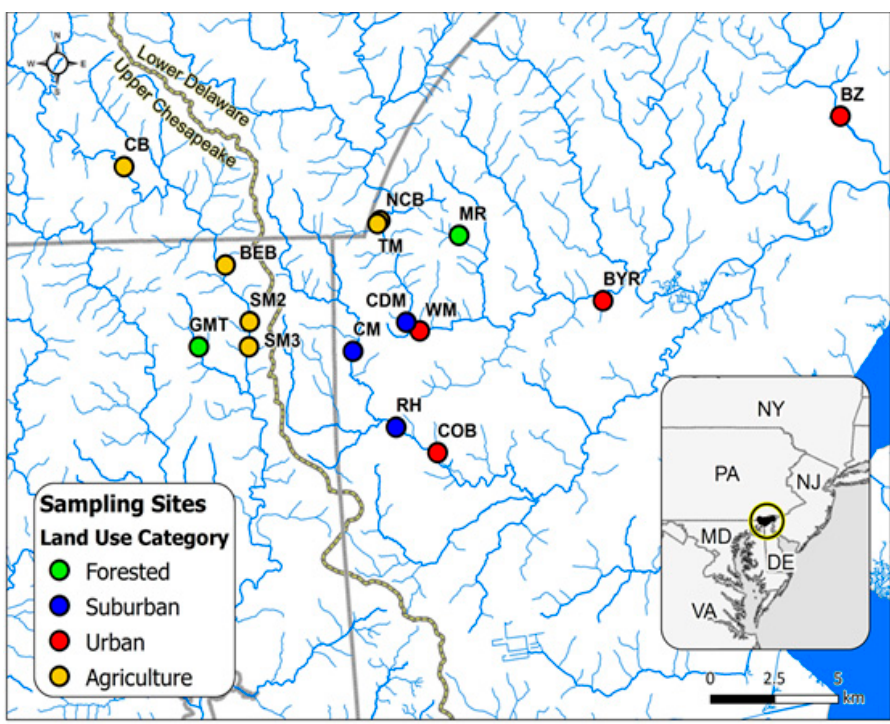
Figure 2. Map showing locations of 15 stream bank sampling sites for legacy sediments across Delaware, Maryland, and Pennsylvania. These sites included: BEB = Big Elk Bridge (Agriculture), CB = Camp Bonsul (Agriculture), NCB = Nature Center Beach (Agriculture), SM2 = Scott’s Mill 2 (Agriculture), SM3 = Scott’s Mill 3 (Agriculture), TM = Tweed’s Mill (Agriculture), RH = Cottage Mill (Suburban), CM = Casho Mill (Suburban), CDM = Cider Mill (Suburban), BZ = Brandywine Zoo (Urban), BYR = Byrnes Mill (Urban), COB = Cooch’s Bridge (Urban), GMT = Gramies Run (Forested) and MR = Middle Run (Forested). Inset: Location of study sites in the mid-Atlantic tristate